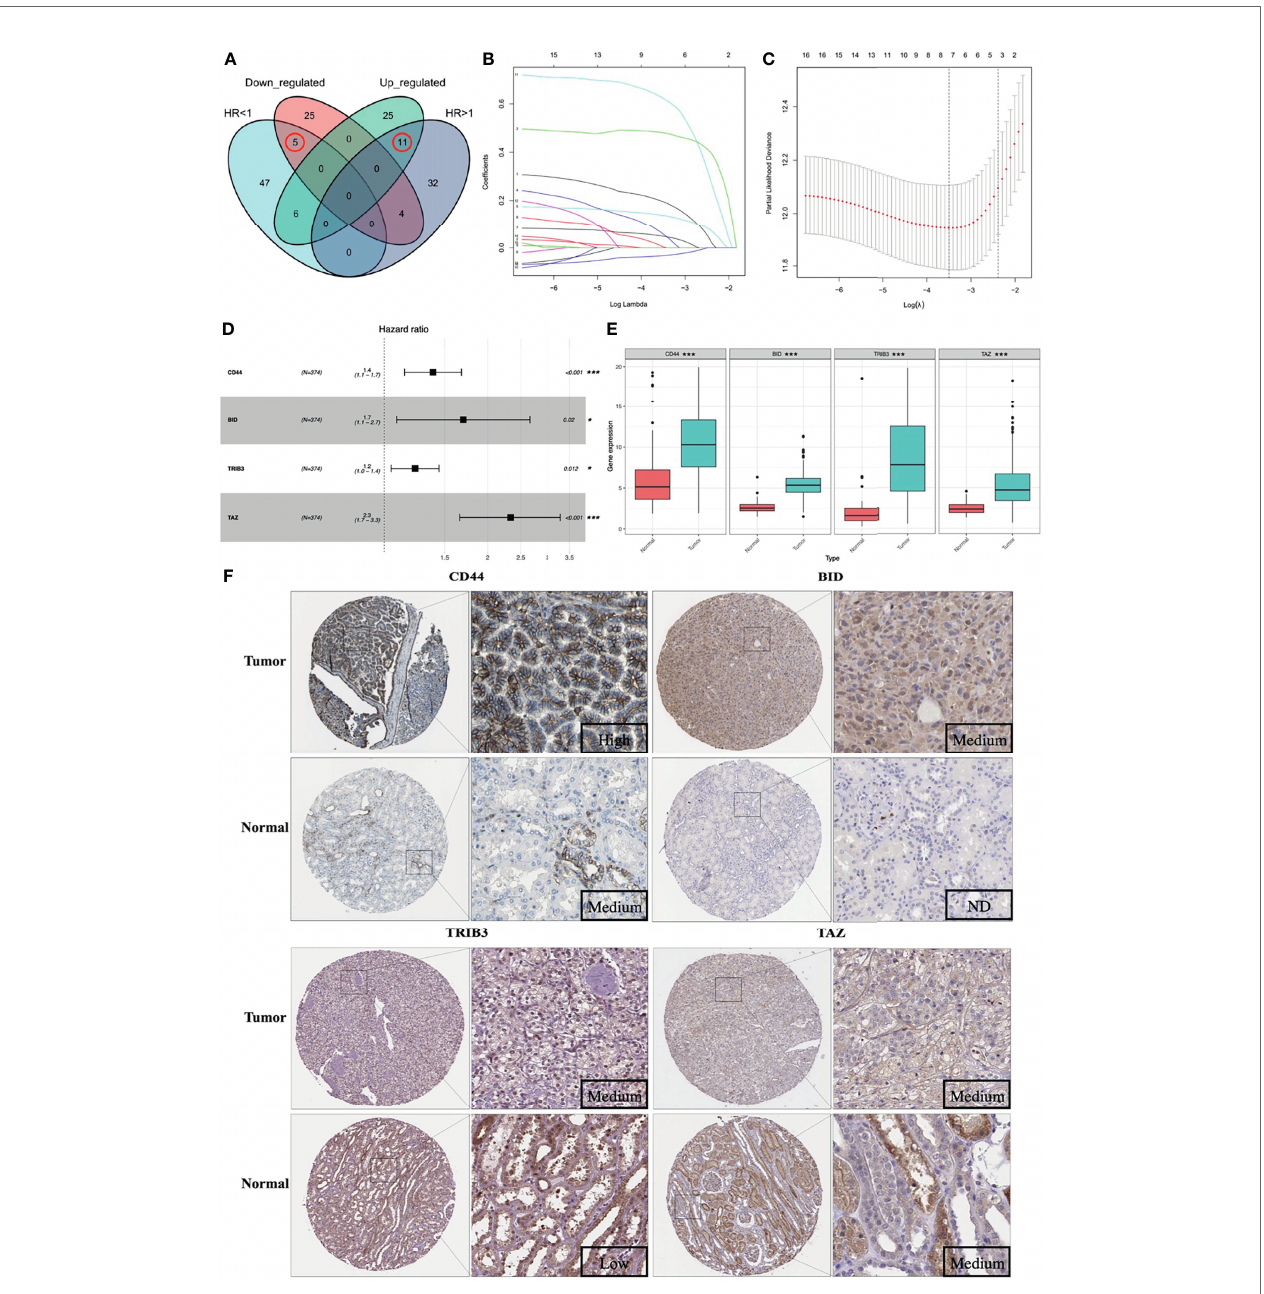
FIGURE 3 | Construction of the prognostic strati fi ed model. (A) Venn diagram of 16 OC-FRGs; (B) LASSO coef fi cients pro fi les of 16 OC-FRGs. (C) The 8 candidate FRGs obtained by LASSO regression with 1000-fold cross-validation to identify the optimal lambda value that came from the minimum partial likelihood deviance. (D) 4 optimal PR-FRGs got by multivariable Cox regression analysis. (E) Expression pattern of the 4 optimal PR-FRGs between tumor and normal specimens. (F) Images of immunohistochemistry staining of the 4 optimal PR-FRGs in tumor and normal specimens from the HPA database. OC-FRGs, overlapping candidate FRGs; LASSO, least absolute shrinkage and selection operator; PR-FRGs, prognosis-related FRGs. ND, not detected. * means p < 0.05 and *** means p <